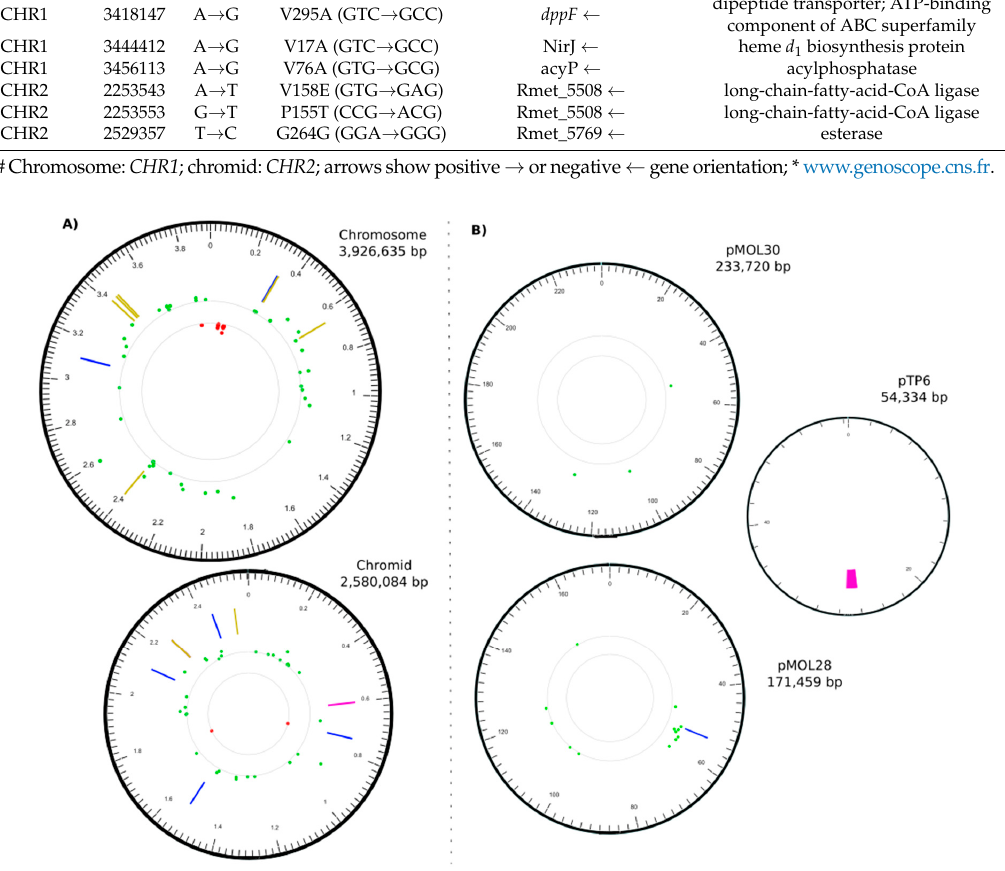
Figure 1. Correlation map between Insertions or Deletions (INDELs), Single nucleotide polymorphisms ( SNPs), and transcriptional changes found for C. metallidurans MSR33. Concentric circles (ring) displayed from the outside inwards: ( A ) In ring 1, chromosome and chromid size scale in megabases (Mb) using a 20 kilobase (kb) window; ( B ) plasmids size scale in kb using a 2 kb window. In ring 2, position of insertion (blue), deletion (pink), and SNPs (mustard). INDELs and SNPs listed in Tables 2 and 3. In ring 3, each dot represents a single gene basal expression, overexpression (log 2 ratio > 1, green), or repression (log 2 ratio < − 1, red), with a p -value < 0.05. Plotted genes listed by function in Table S7. Circos plot created with Circa (http://omgenomics.com/circa).